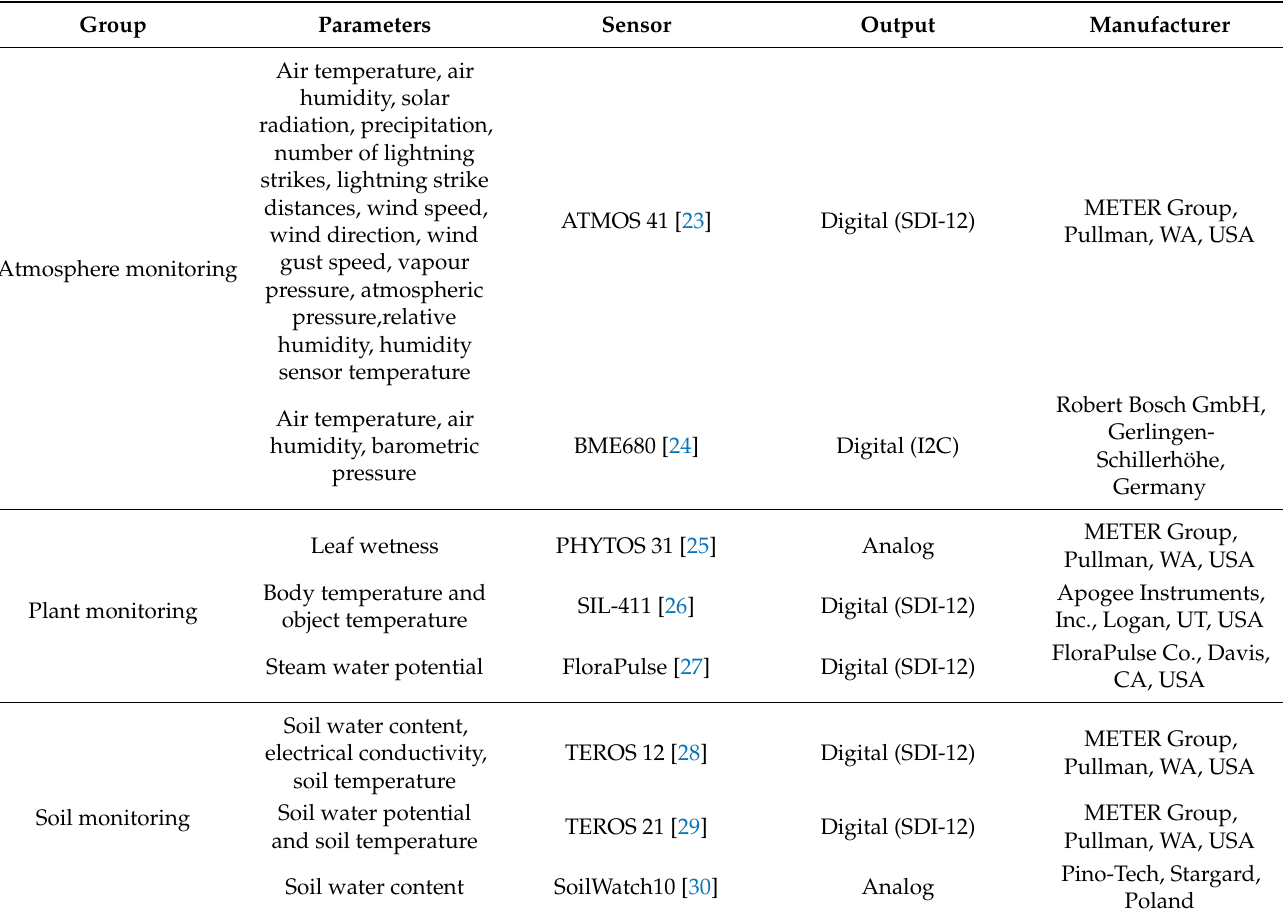
Table 1. Groups of sensors tested in field experiments along with parameters